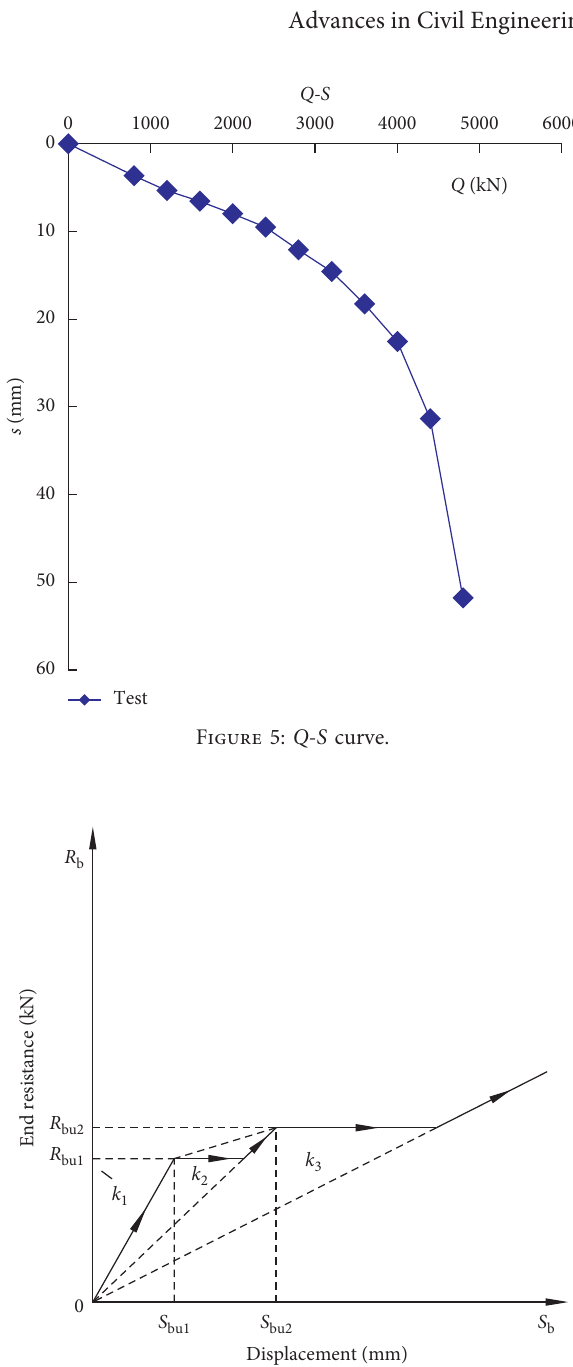
Figure 6: Illustration of load transfer function at the end of a slowly changing